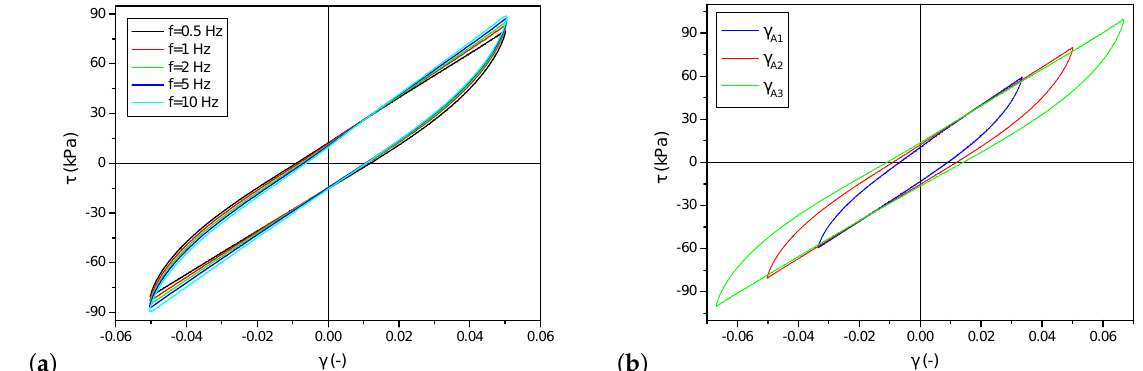
Figure 3. Experimental research results: ( a ) stress and deformation as a function of time for selected value of magnetic field and deformation amplitude; and ( b ) hysteresis loops τ ( γ ) for a few selected values of magnetic field at constant values of strain amplitude and strain rate.